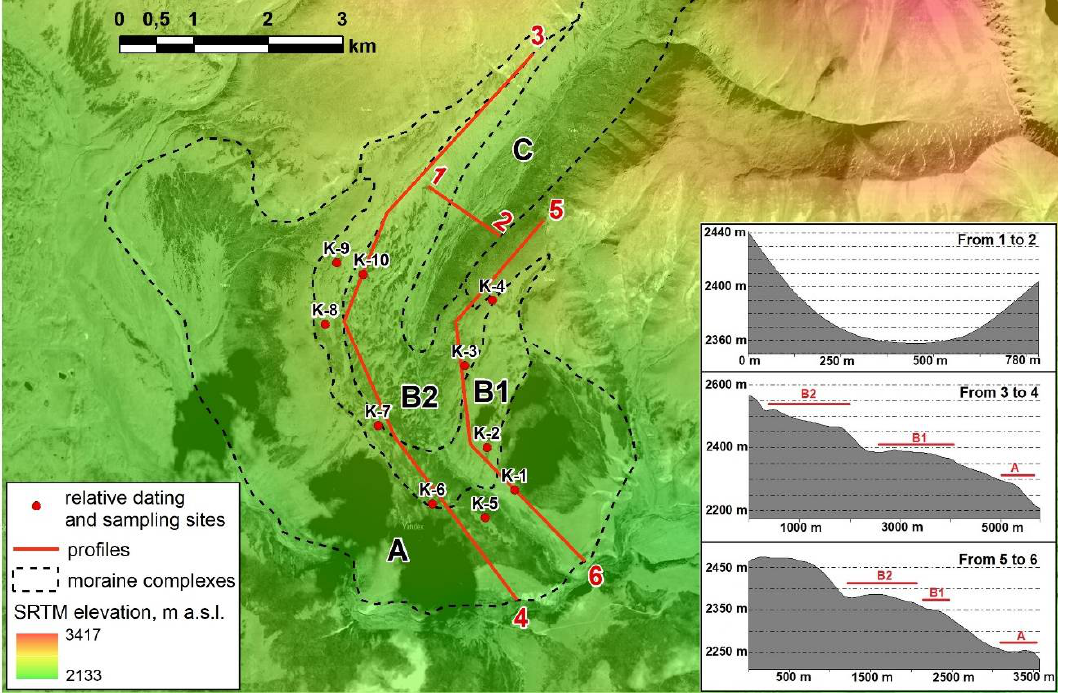
Figure 3. Spatial distribution of moraines and profiles of the Kargy River’s valley (based on a Sentinel-2 image and semi-transparent digital elevation model SRTM [64]). Profiles were created in Global Mapper. A–C represent groups of moraines.